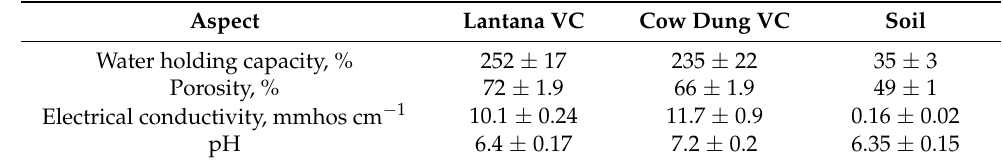
Table 1. Cont. Aspect Lantana VC Cow Dung VC